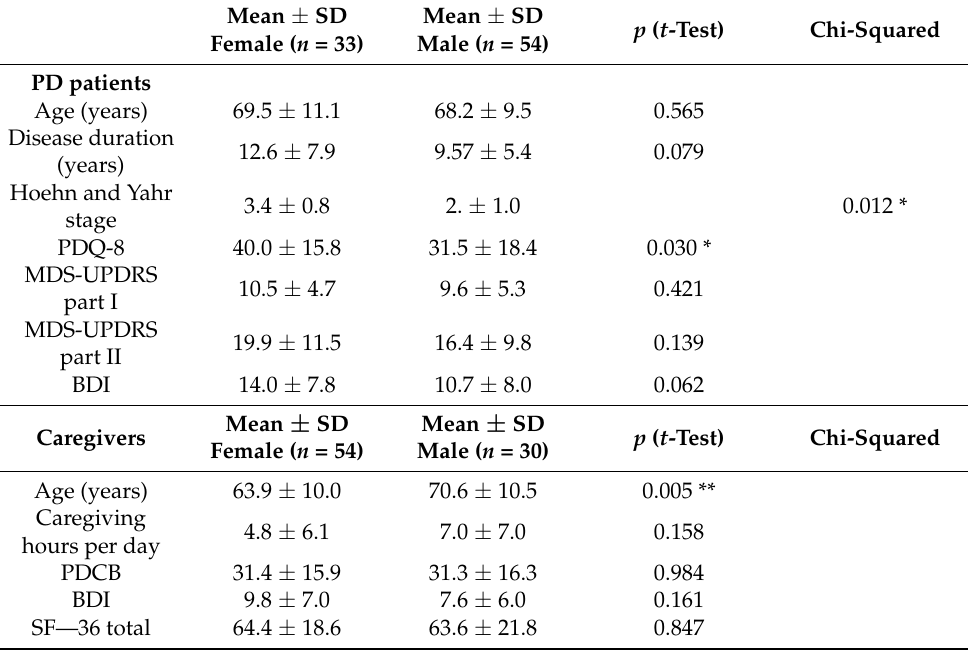
Table 3. Patient and caregiver characteristics, separated by